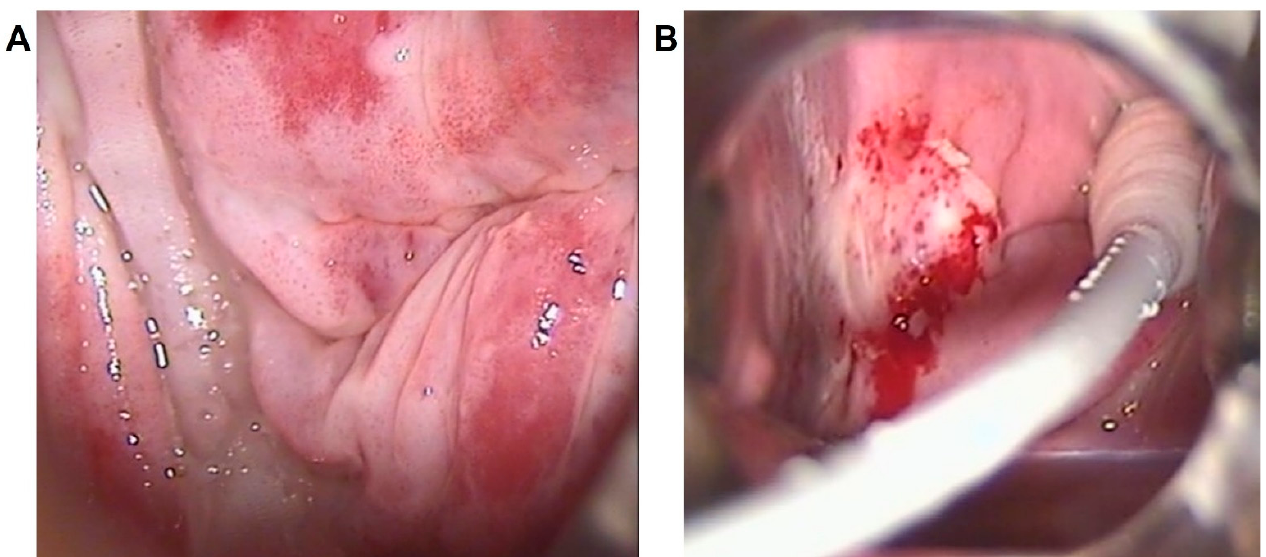
Figure 3. Vascular pattern. Colposcopic findings showing: dense acetowhite epithelium with coarse punctuation at the posterolateral right vaginal fornices and upper-third walls in a young woman (35 years) affected by VAIN3 ( A ); and dense acetowhite epithelium with fragile vessels at the upper- middle third of the right vaginal wall in a post-menopausal woman (62 years) affected by VAIN2 ( B ).